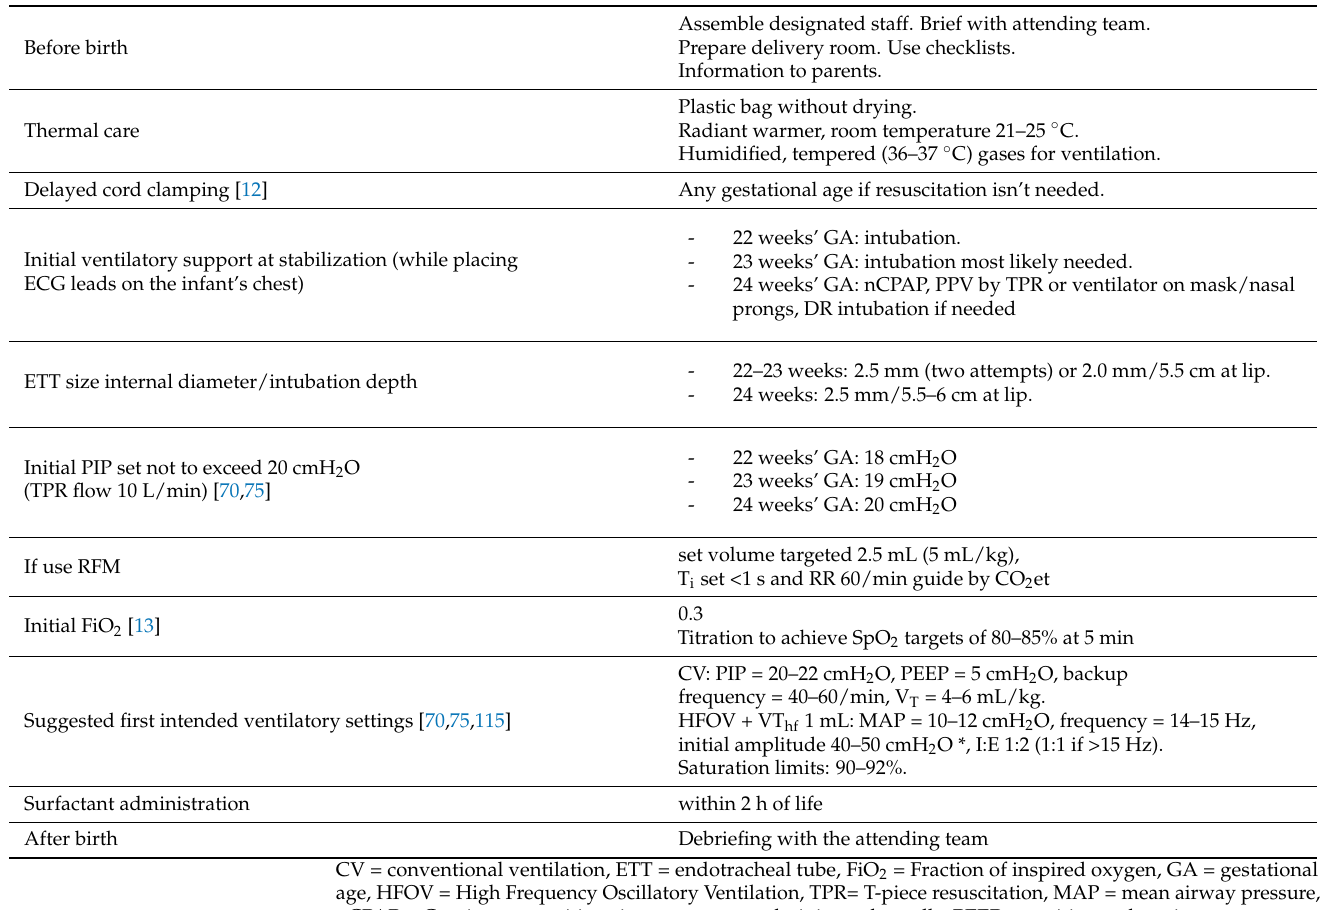
Table 4. Strategies for the management of preterm infants in the limit of viability (22–23 weeks GA) in the golden hour following the suggestions of neonatal centers with greater experience in the treatment of micro-preemies [13,66,70,75,115,116]. Modified from Norman et al. Semin Fetal Neonatal Med. 2022